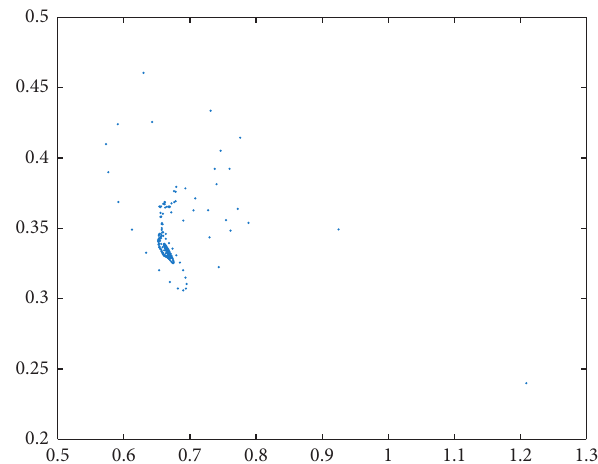
Figure 2: The phase graph of Example 1 in t � 500 with the equilibrium points p ∗